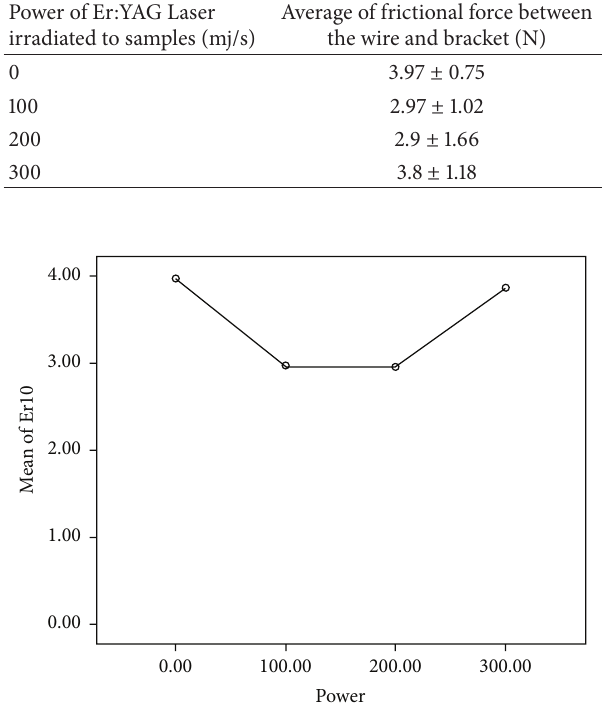
Figure 4: This diagram shows the changes in frictional forces (N) between the wire and bracket at 10 ∘ of angulation of wire with an increase in the laser power